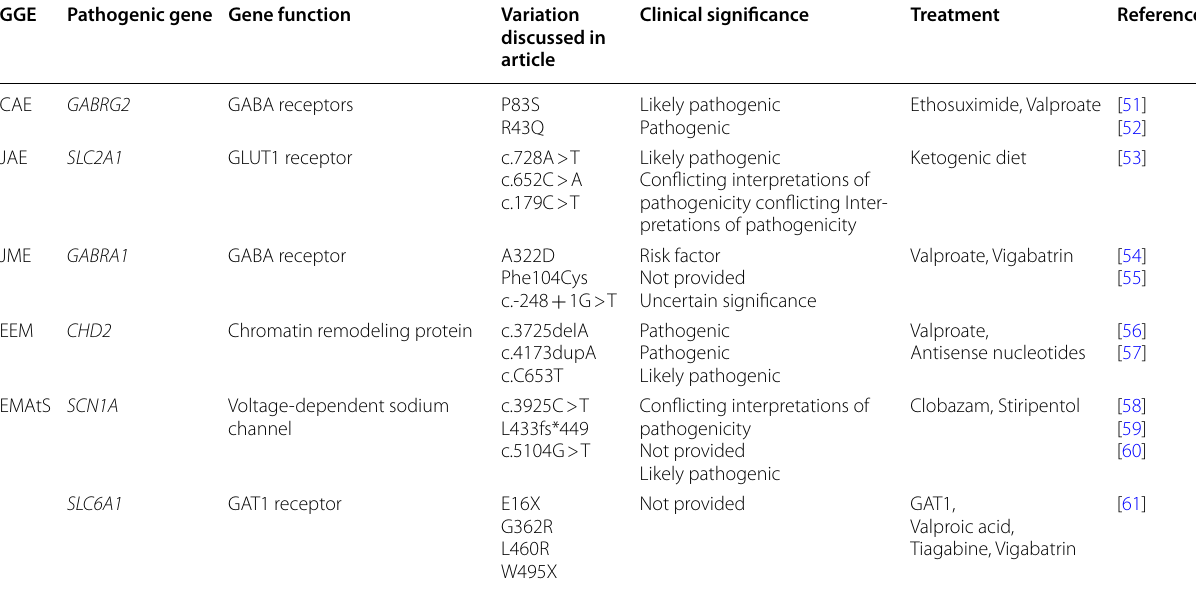
Table 1 Proposed pathogenic gene, genetic function, variation, and therapeutic plan for reference GGE Pathogenic gene Gene function Variation discussed